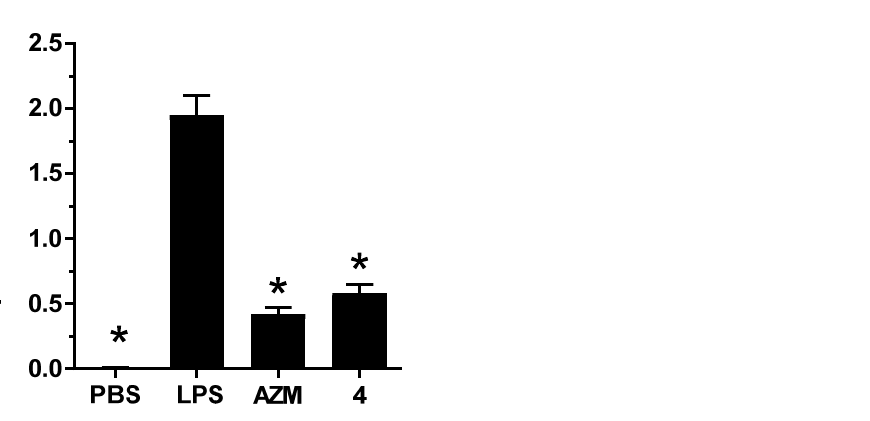
Figure 3. Neutrophil number in BALF 24 h after intranasal LPS challenge of BALB/cJ mice. Com- pounds were administered at a dose of 200 mg/kg intraperitoneally 2 h prior LPS challenge. Data are presented as means ± S.E.M. of 8 animals per group Asterisk represents p < 0.05, one-way ANOVA followed by Dunnett’s multiple comparison test.